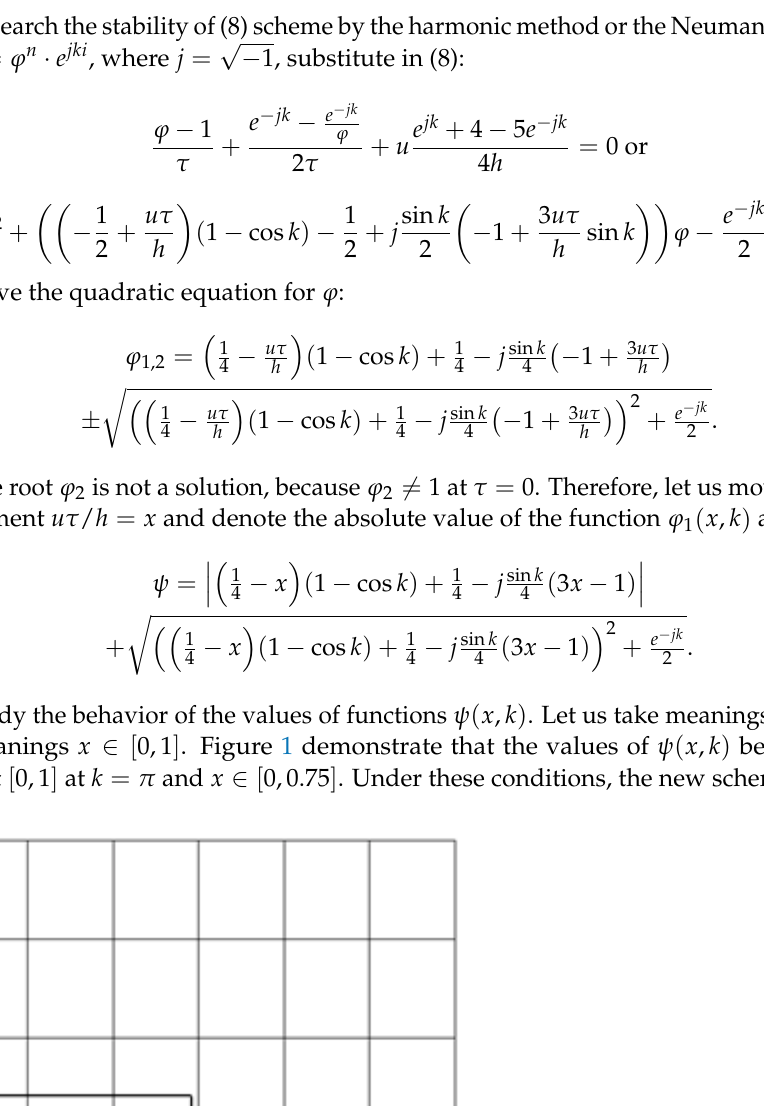
Figure 1. The function